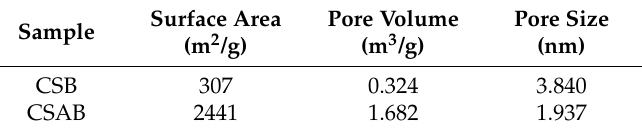
Table 1. BET characteristics of biochar samples.